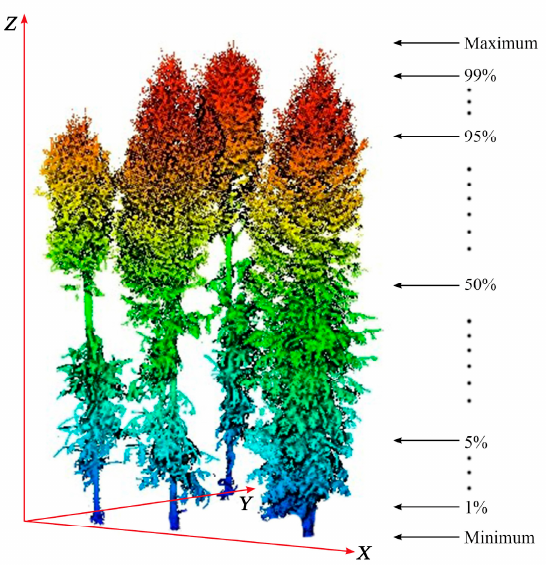
Figure 3. Diagram of point cloud feature variables. The point cloud space is divided into different grids, according to certain distances in the x and y directions, and then further divided into different “layers”, according to the specified height (z) interval.